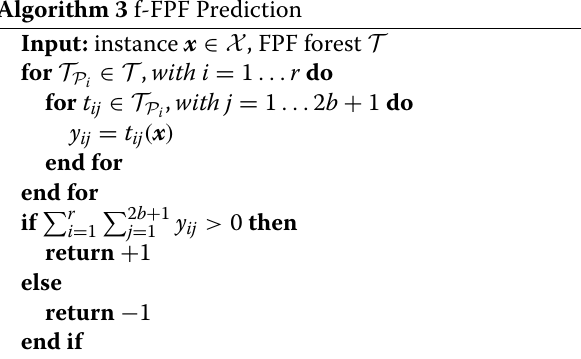
Algorithm 3 f-FPF